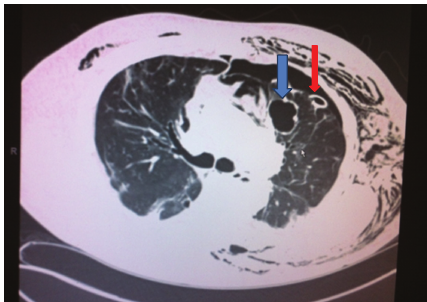
Figure 4: Chest CT with contrast after one month of axitinib that showed left pneumothorax, cutaneous emphysema, thoracic tube (red arrow), and necrotic RCC metastasis in the left lung (blue